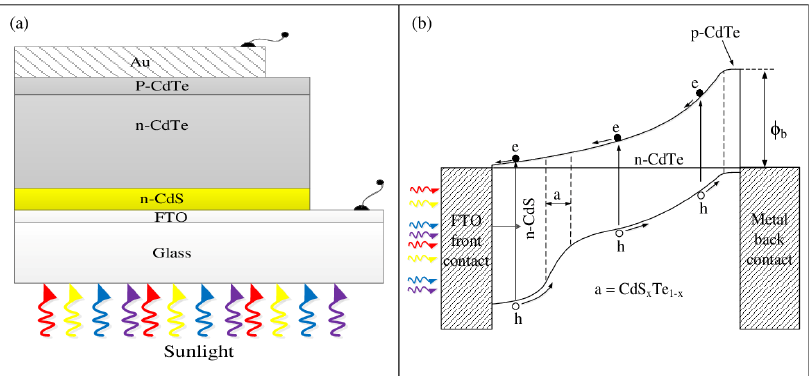
Figure 13. ( a ) Schematic diagram and ( b ) energy band diagram of the glass/FTO/n-CdS/n-CdTe/p- CdTe/Au thin-film solar cell [44].